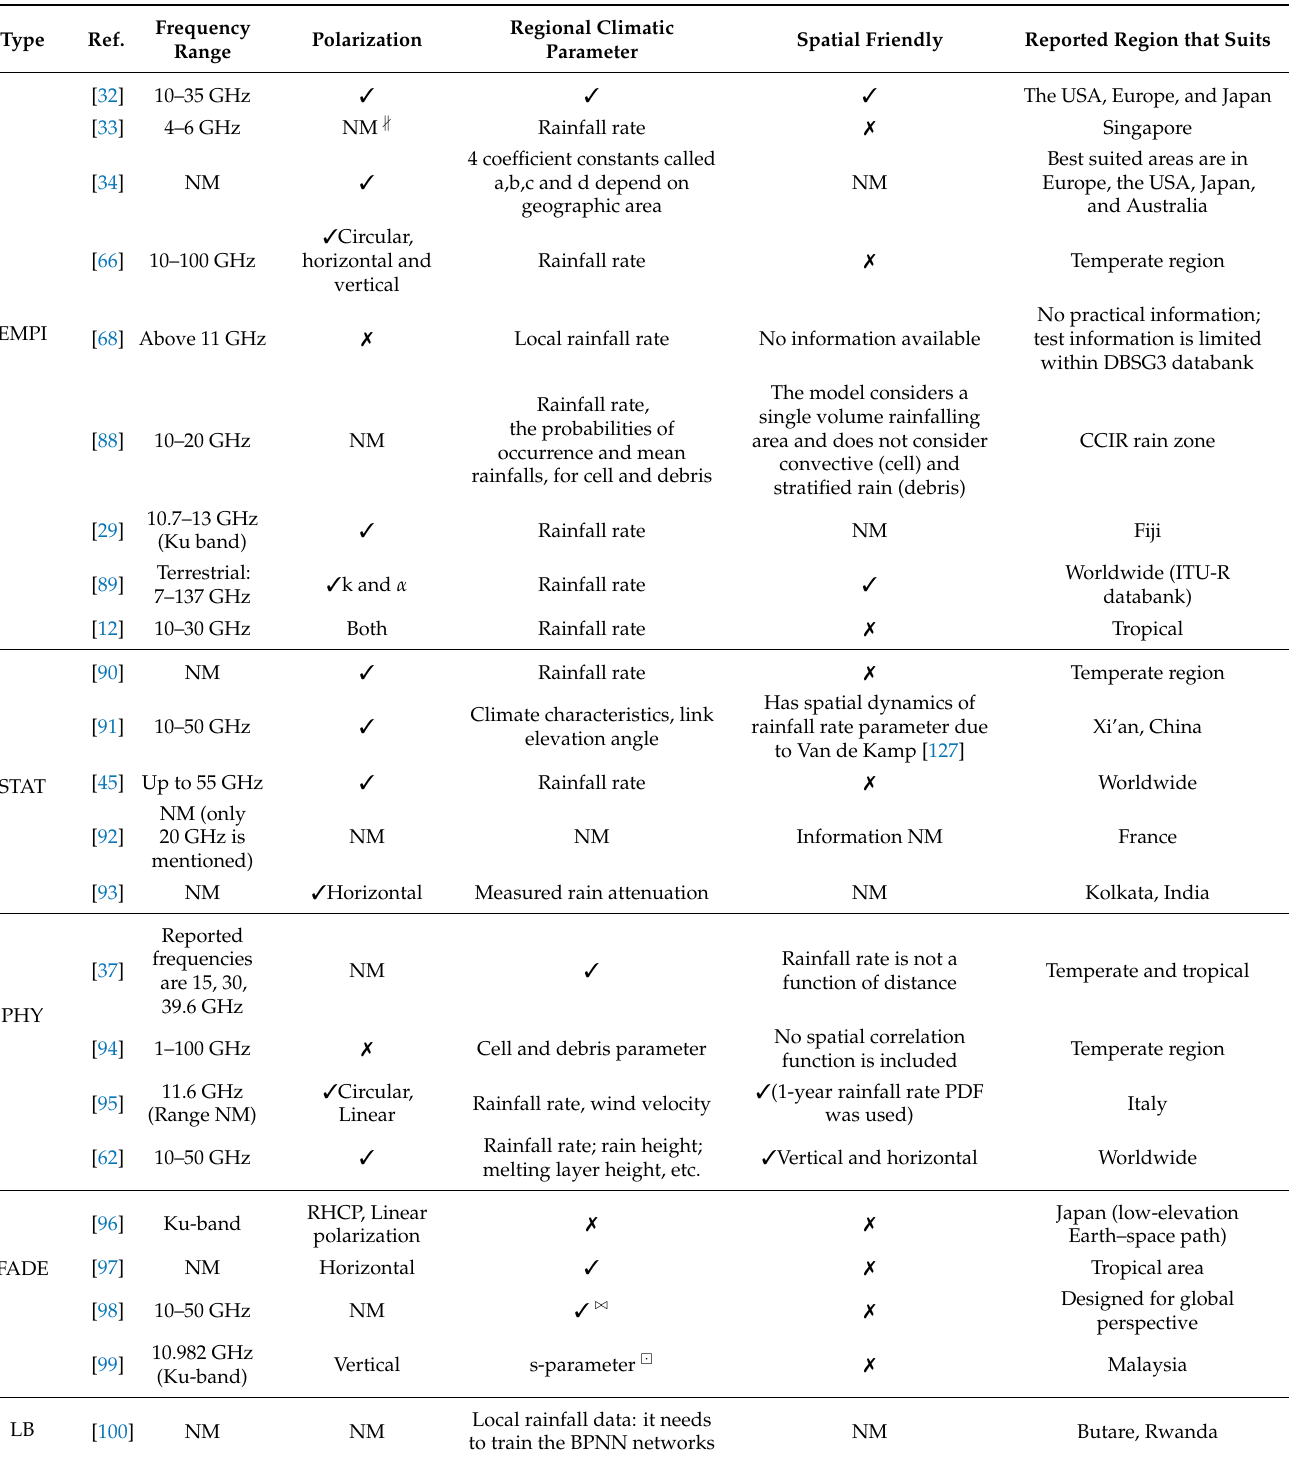
Table 8. Characteristics